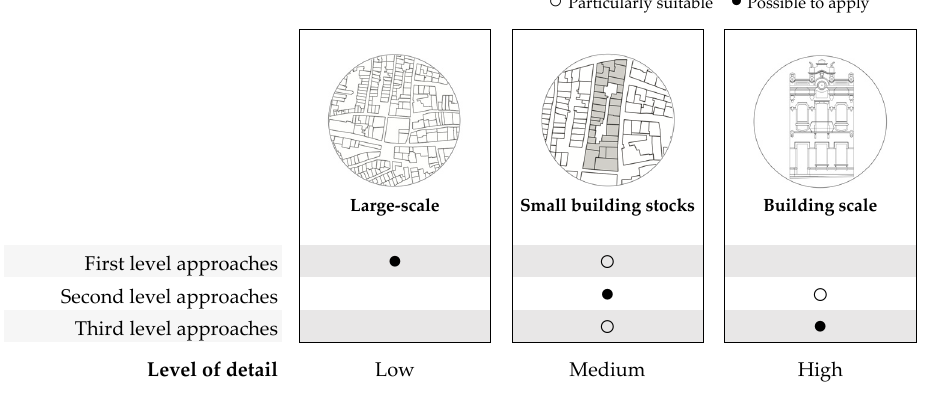
Figure 1. Analysis techniques versus assessment scales.